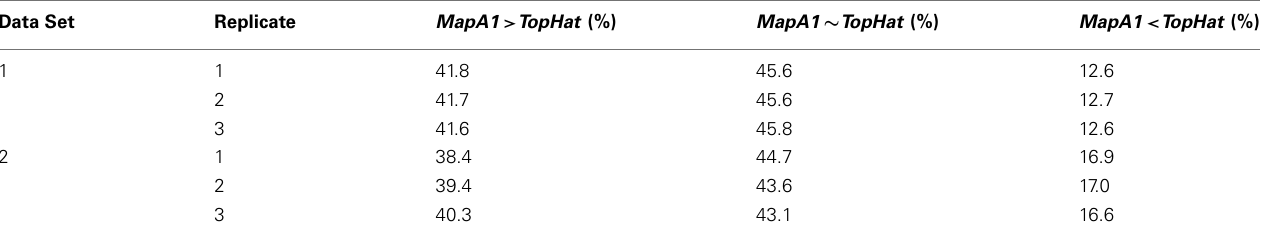
TableA2 | Comparison of expression level